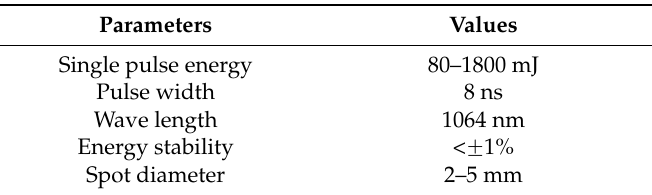
Table 1. Main parameters of Spitlight 2000 Nd-YAG laser.